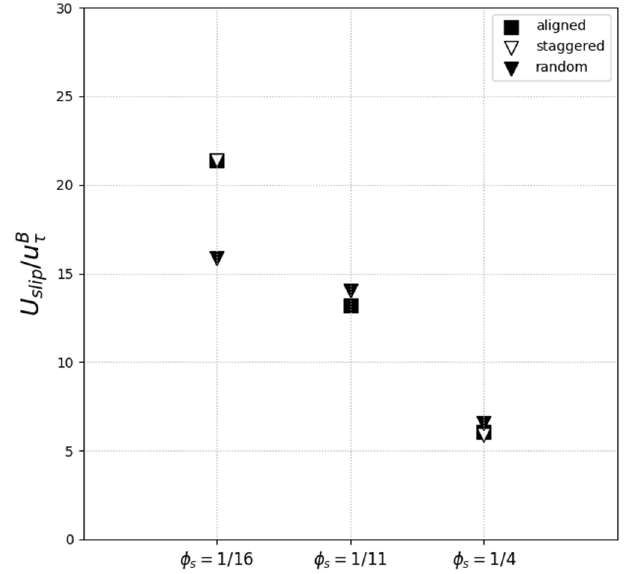
Figure 12. Slip velocity normalized by the bottom wall friction velocity for three different distributions of post type: ( ■ ) aligned, ( ▽ ) staggered, and ( ▼ ) random distributions.